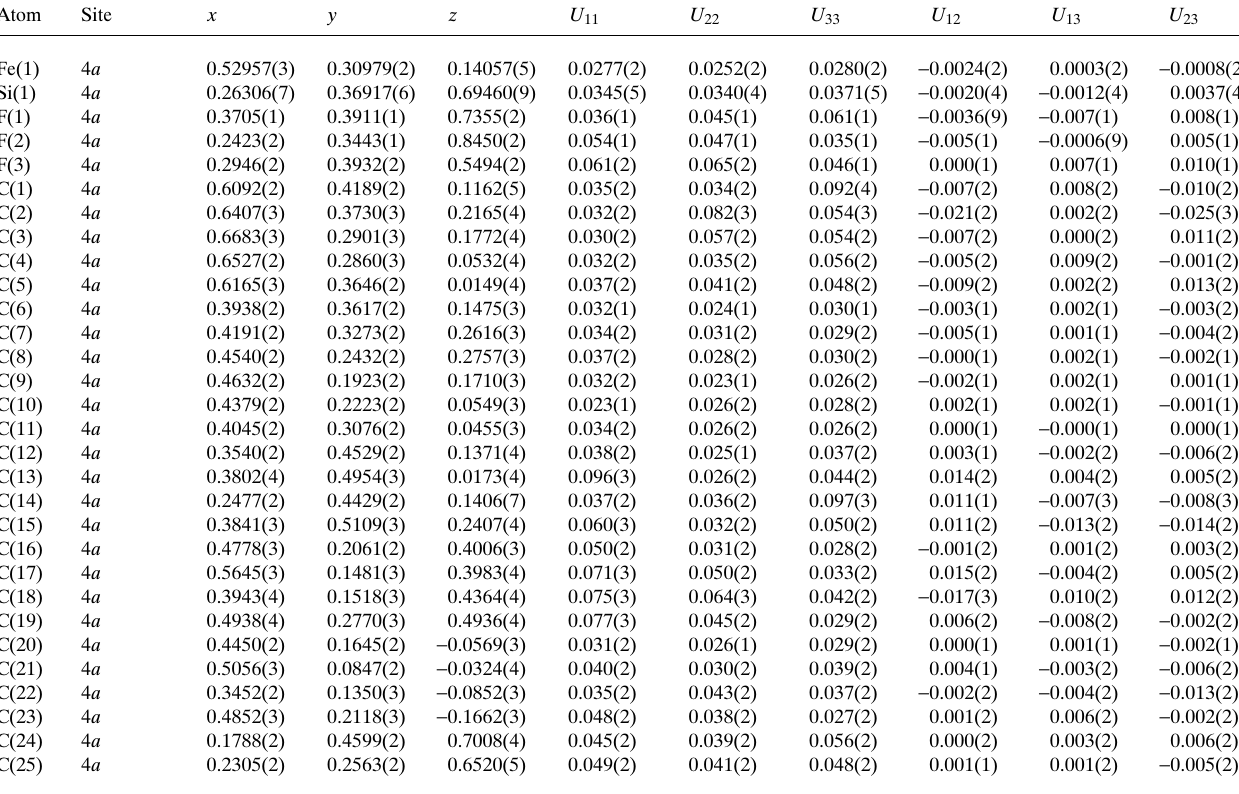
Table 3. Atomic coordinates and displacement parameters (in Å 2 )